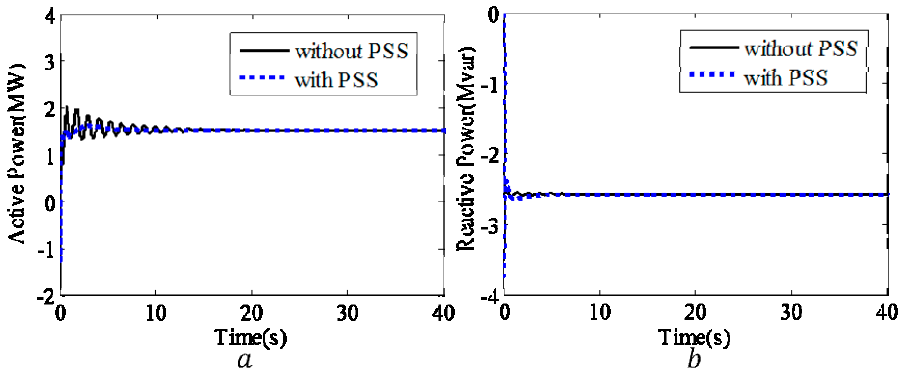
Figure 16. ( a ) Active power and ( b ) reactive power with and without PSS.